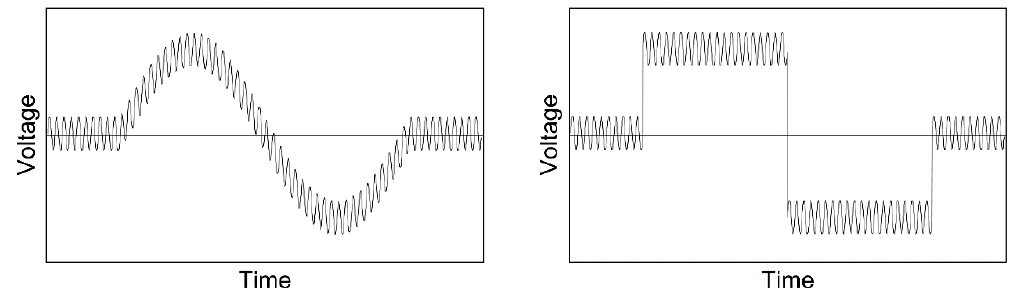
Figure 8. Composite input voltages where a high-frequency component for sensing the resistance is added to the low-frequency driving